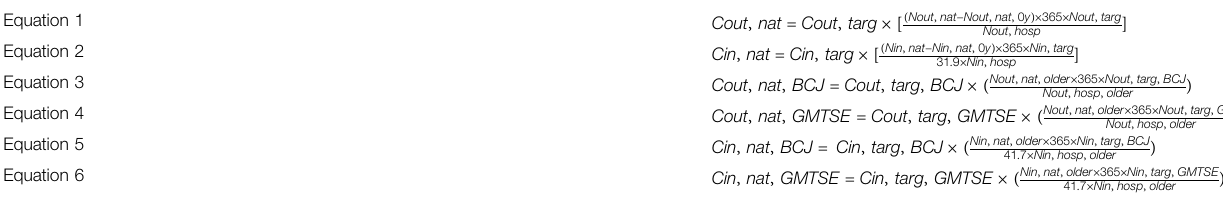
TABLE 1 | Calculation of